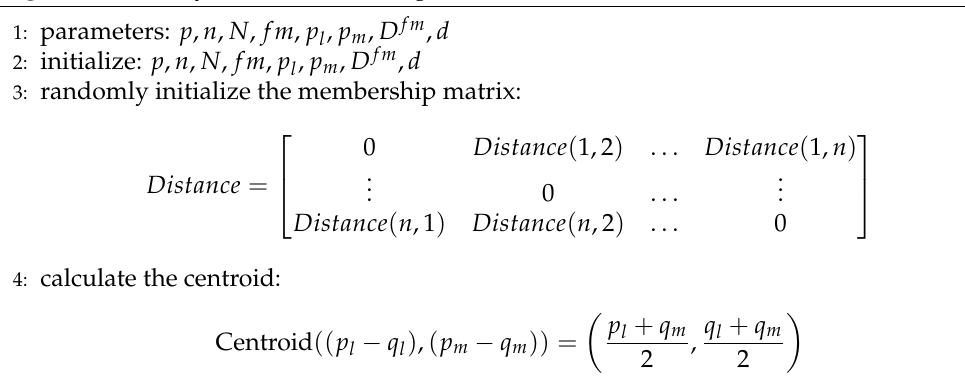
Algorithm 1 Fuzzy C -means